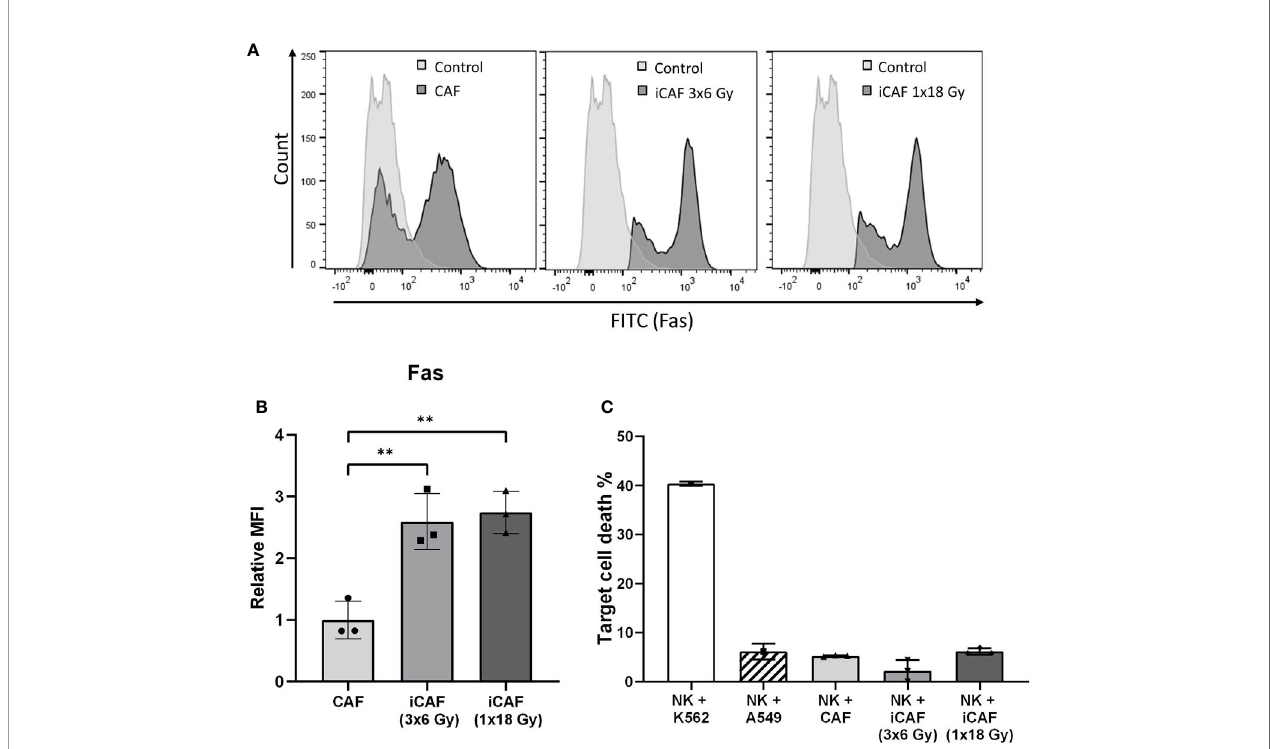
FIGURE 2 | Radiation-induced Fas-receptor on cancer-associated fi broblasts (CAFs) and natural killer (NK) cell-mediated killing. Panels in (A) show fl ow cytometry histograms comparing surface expression of Fas receptor in irradiated and non-irradiated CAFs from a representative donor. Control histograms represent CAFs exposed to isotype control antibodies. (B) Quantitative expression of Fas receptor presented as median fl uorescence intensity (MFI) calculated from three independent CAF donors. (C) NK cell cytotoxicity assay measuring NK cell mediated cell killing of irradiated or non-irradiated CAFs as targets, in addition to two different control target cell types at NK to target ratio 5:1. Bars represent mean (± SD) from three independent CAF donors. Statistics and P -values between NF and CAFs were determined using one-way ANOVA with Tukey correction for multiple comparisons. ** indicates P <